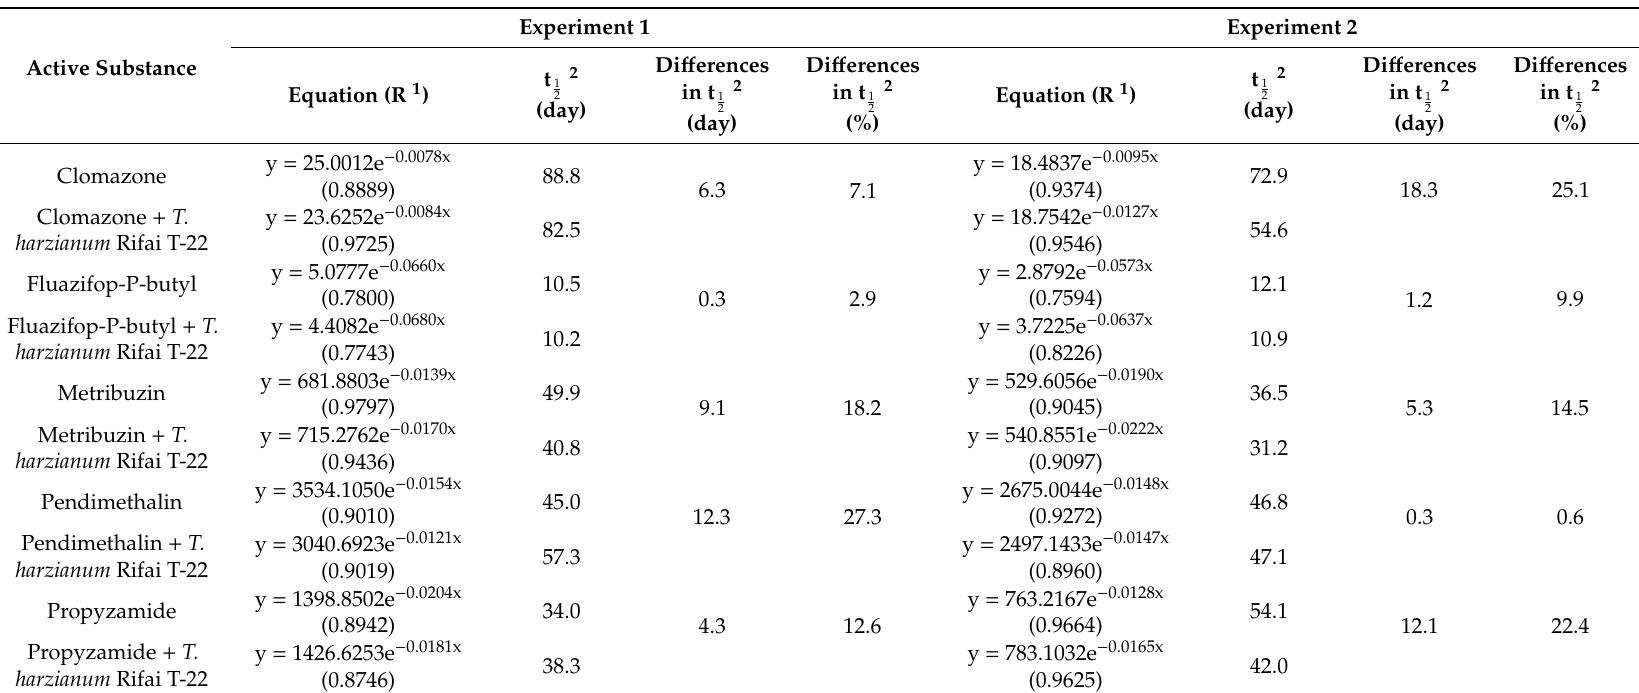
Table 2. Dissipation parameters of herbicides in soil without and with T. harzianum Rifai T-22 added, and di ff erences in their half-lives between soils with and without